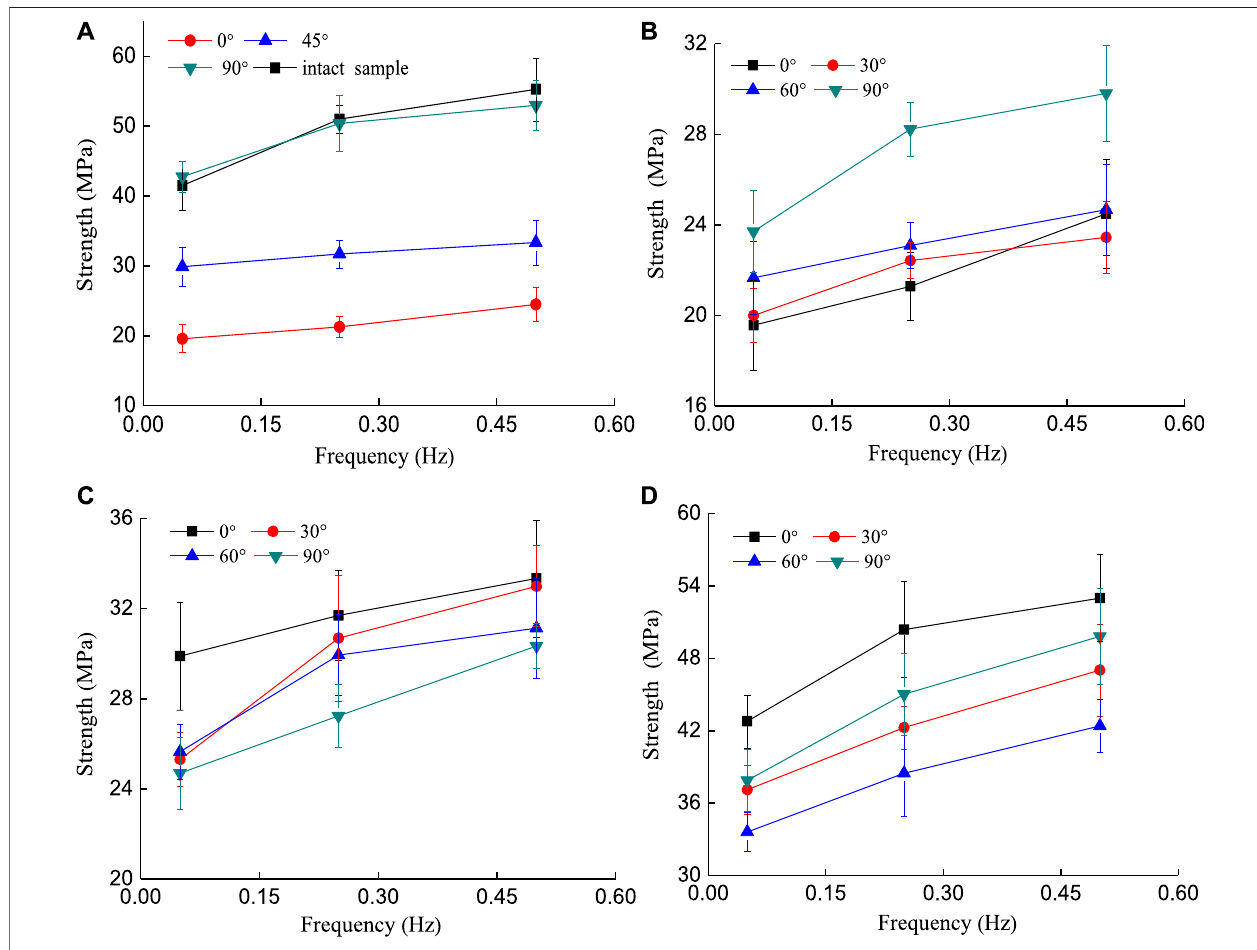
FIGURE 10 | The relationship between strength of cracked samples and frequency. (A) Single crack samples with different inclination angles, (B) T-shaped crack samplescontainingthemajor fi ssureinclinationangleof0 ° , (C) T-shapedcracksamplescontainingthemajor fi ssureinclinationangleof45 ° , (D) T-shapedcracksamples containing the major fi ssure inclination angle of 90 °